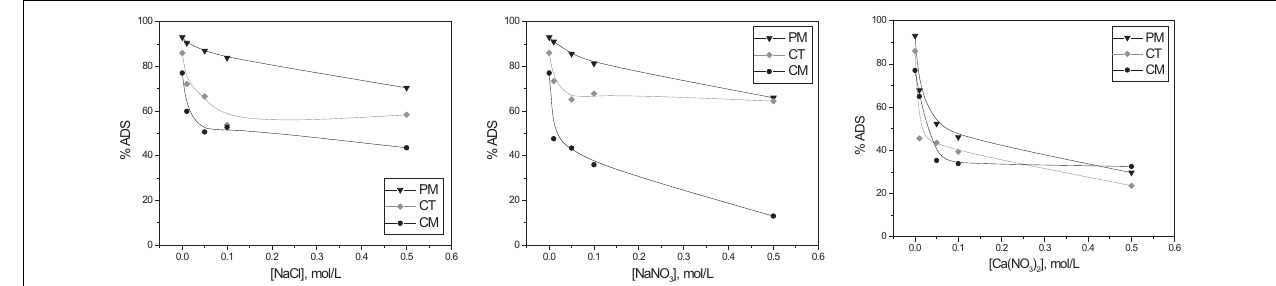
FIGURE 4 | Role of salinity on the adsorption of BY57 onto tea leaves.